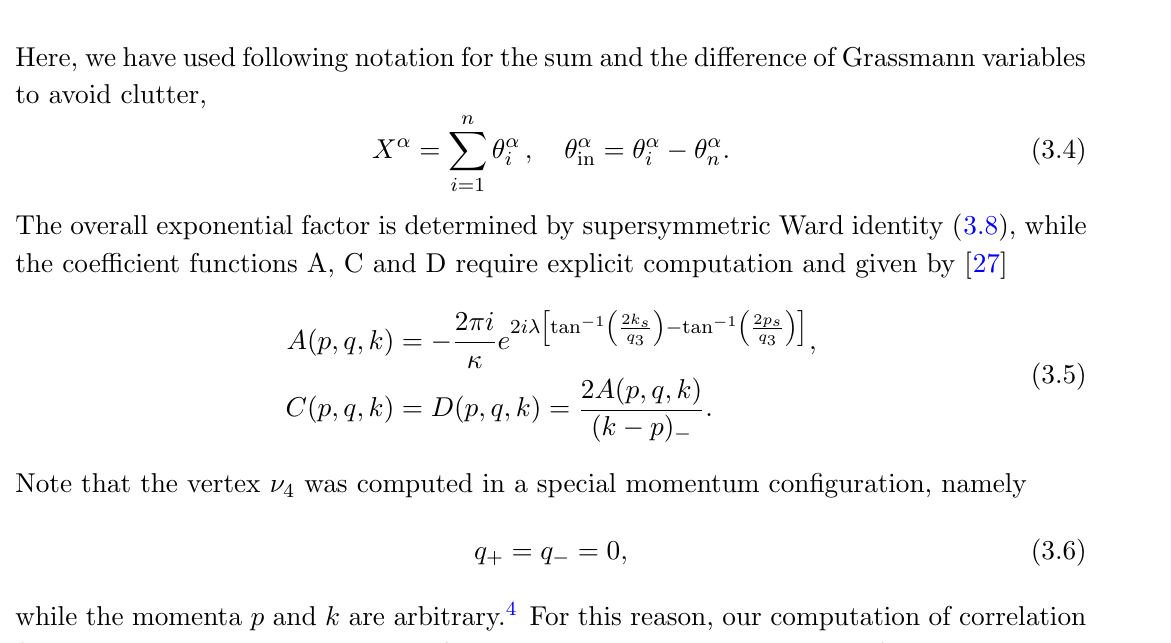
Figure 1 . Diagrammatic representation of the exact four point vertex, (cid:23) 4 in